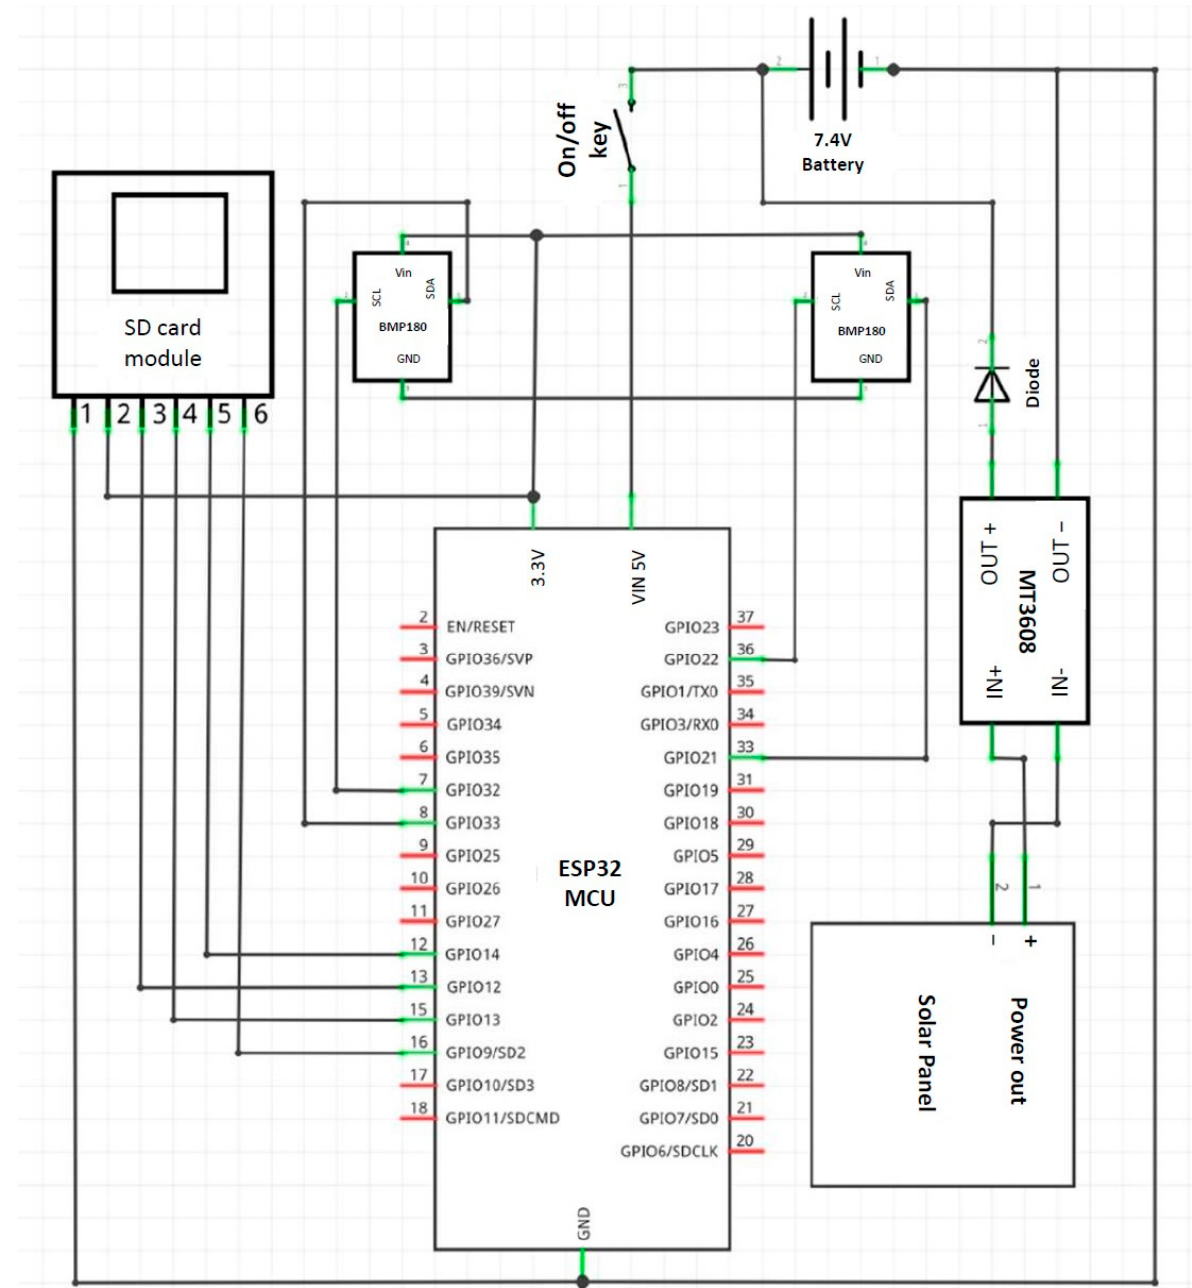
Figure 2. Connection scheme done with Fritzing.